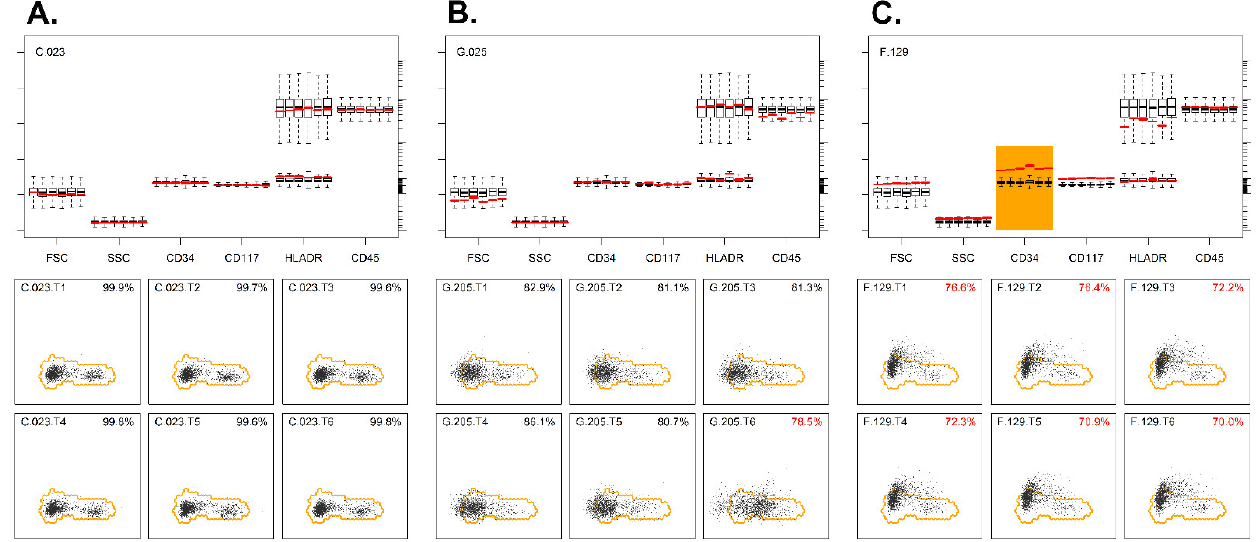
Figure 2. Evaluation of the backbone markers using PCA. ( A ) Example of a sample where the lymphocytes of all six tubes were well located within the reference region (lower panel). Median values of these lymphocytes (in red lines) were close to the median values of the reference cases (upper panel). ( B ) Example of a sample where lymphocytes of five out of six tubes were well located within the reference region (lower panel). The lymphocytes from tube 6 were, however, partly outside the reference region, and the direction of deviation was highly suggestive of abnormal HLADR expression. The median HLADR expressions of the patient’s lymphocytes (red lines) in tube 6 were clearly higher than the median values of the reference cases (upper panel). ( C ) Example of a sample where the lymphocytes of all six tubes are located outside the reference region (lower panel). Median CD34 expressions of the patient’s lymphocytes (red lines) were clearly above the median values of the reference cases, whereas the other BB markers showed normal expression (upper panel). The percentages indicate the number of cells within the reference region. Codes in the upper left part of plots refer to center, case number, and tube (T) number. Median values out of reference are highlighted in orange.